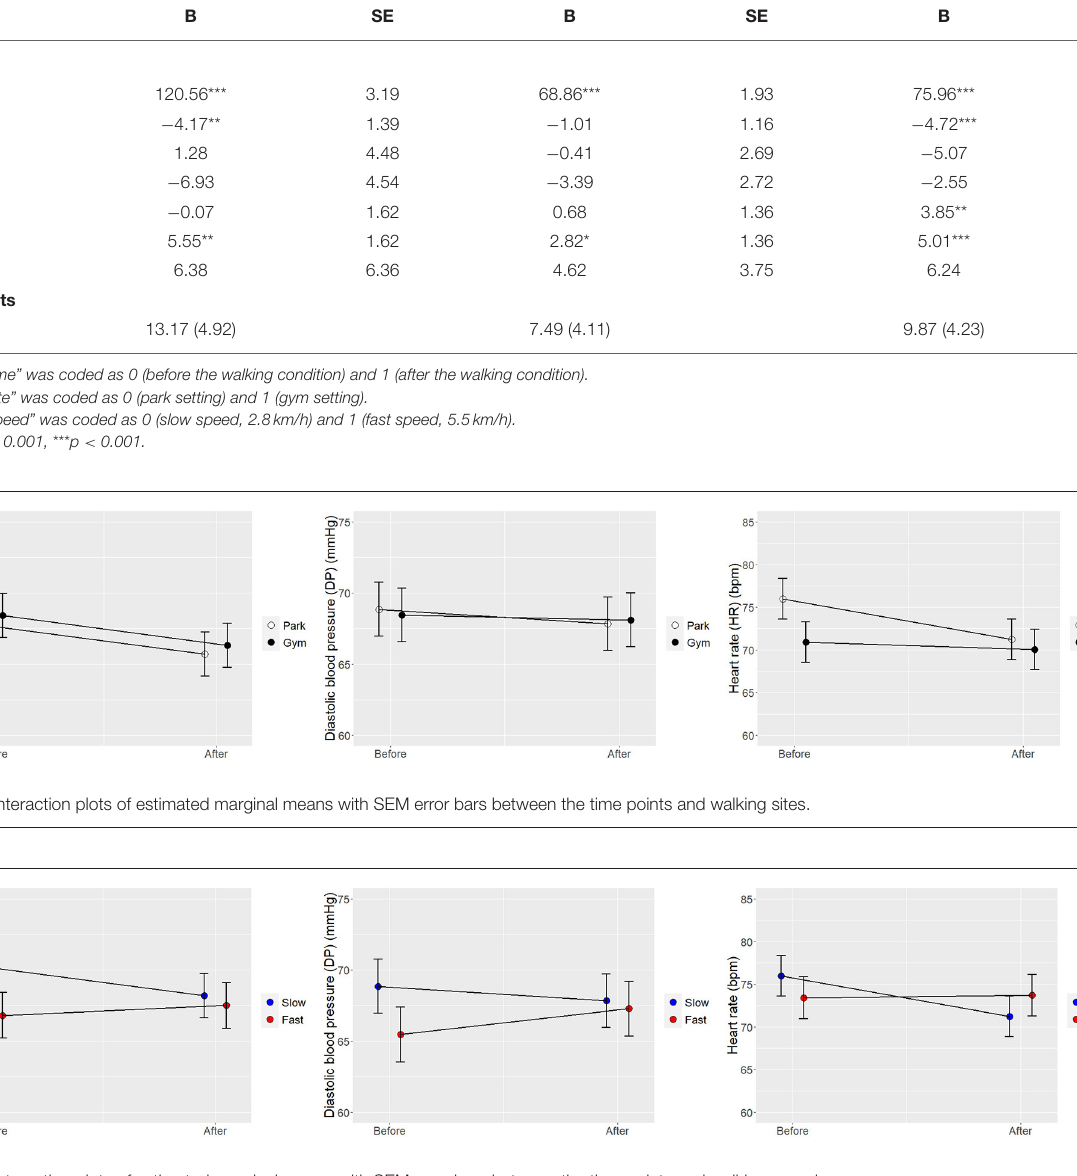
FIGURE 5 | Interaction plots of estimated marginal means with SEM error bars between the time points and walking